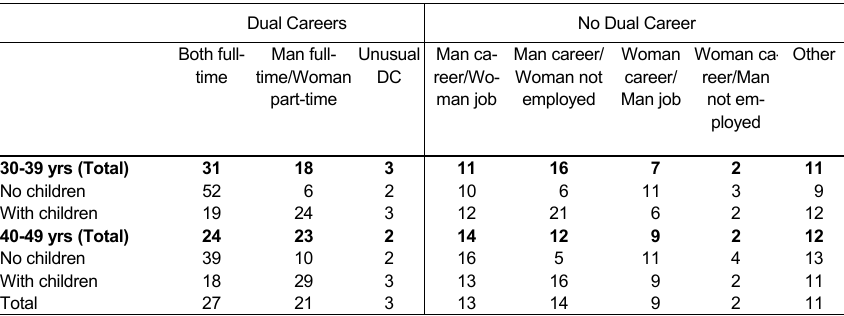
Employment/Career constellation depending on age of the woman and presence of underage children* in academic couples, 2004 (in rounded row percentages) Dual Careers No Dual Career Both full- Man full- Unusual Man ca- Man career/ Woman Woman ca- reer/Man time time/Woman DC reer/Wo- Woman not career/ not em- part-time man job employed Man job